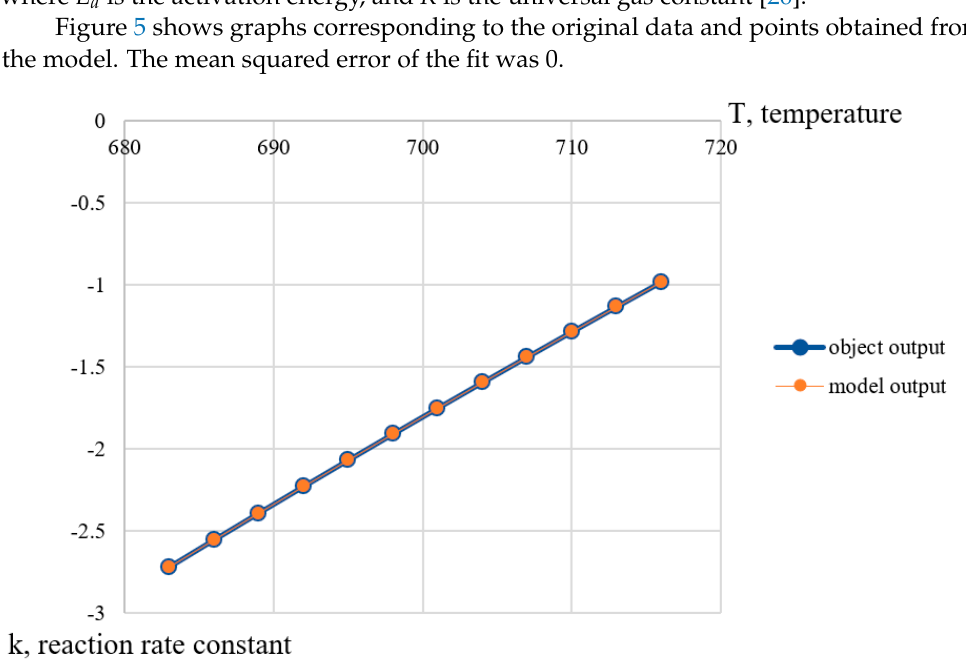
Figure 5. Initial sample fit with the output of the obtained model of the change in the rate of a chemical reaction on temperature.